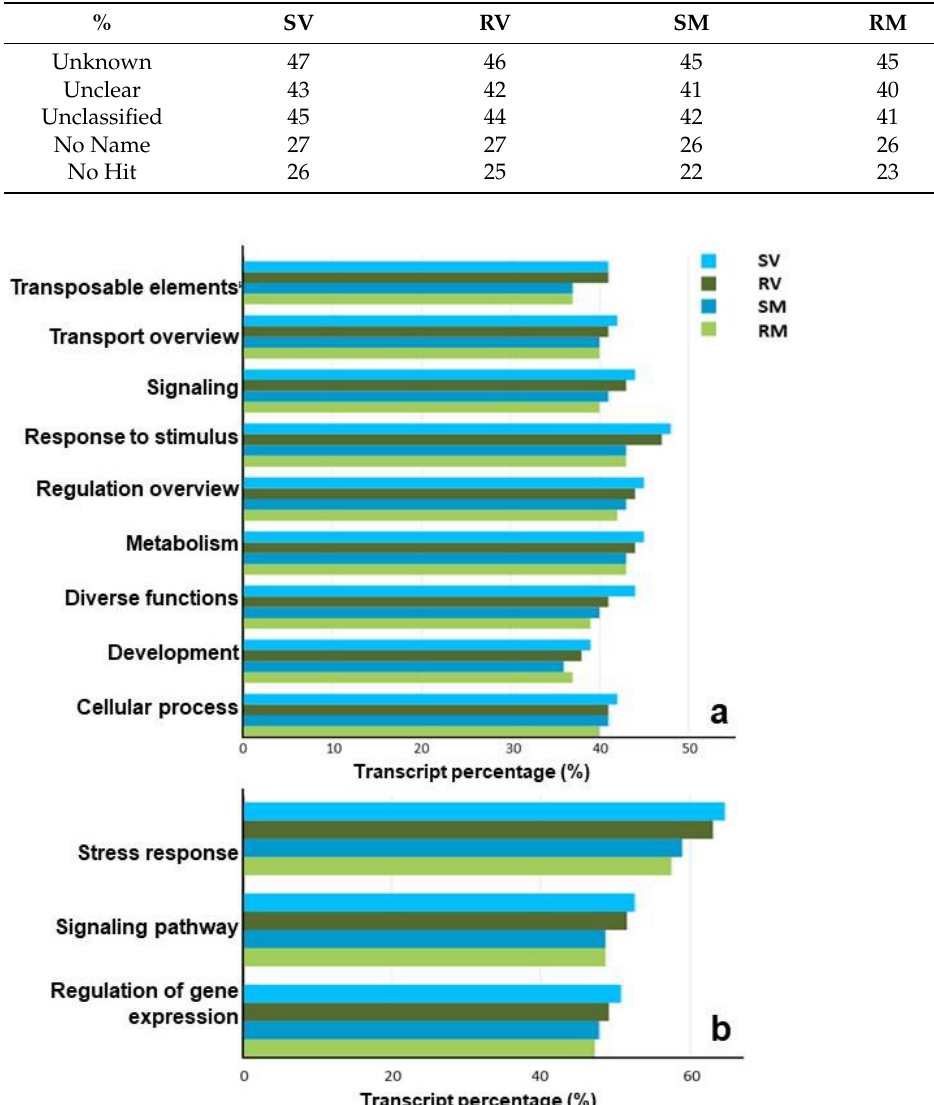
Table 2. Functional profiling of the expression of all non-annotated transcript categories for each RNA-Seq library according to each transcript functional category. The number of transcripts (length ≥150 and RPKM ≥1) per functional category was divided by the total transcripts from that category